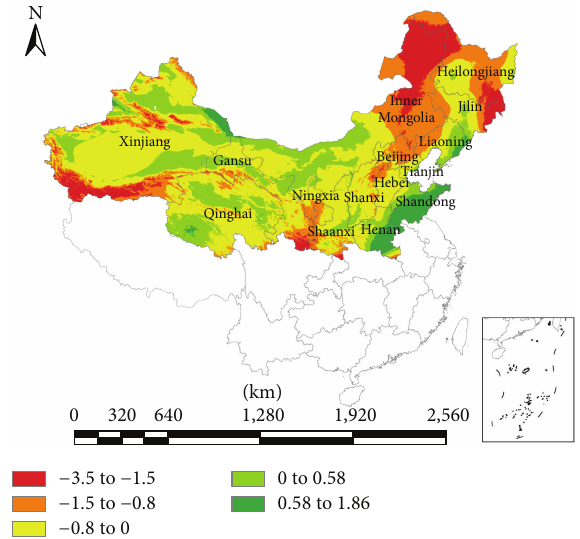
Figure 2: Slope of moisture index in northern China from 1989 to 2008.